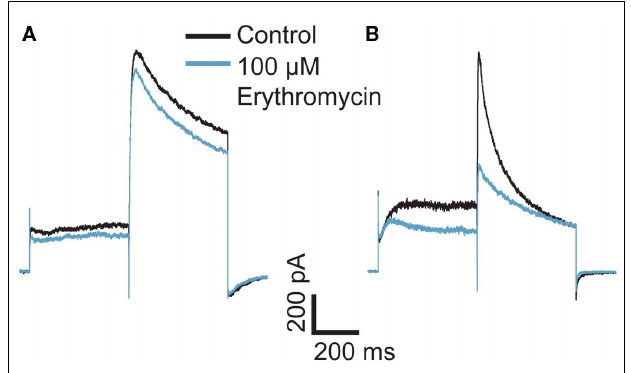
FIGURE 1 | Effect of erythromycin on hERG-mediated currents at (A) room temperature and (B) 35˚C. The graphs are shown on the same scale.